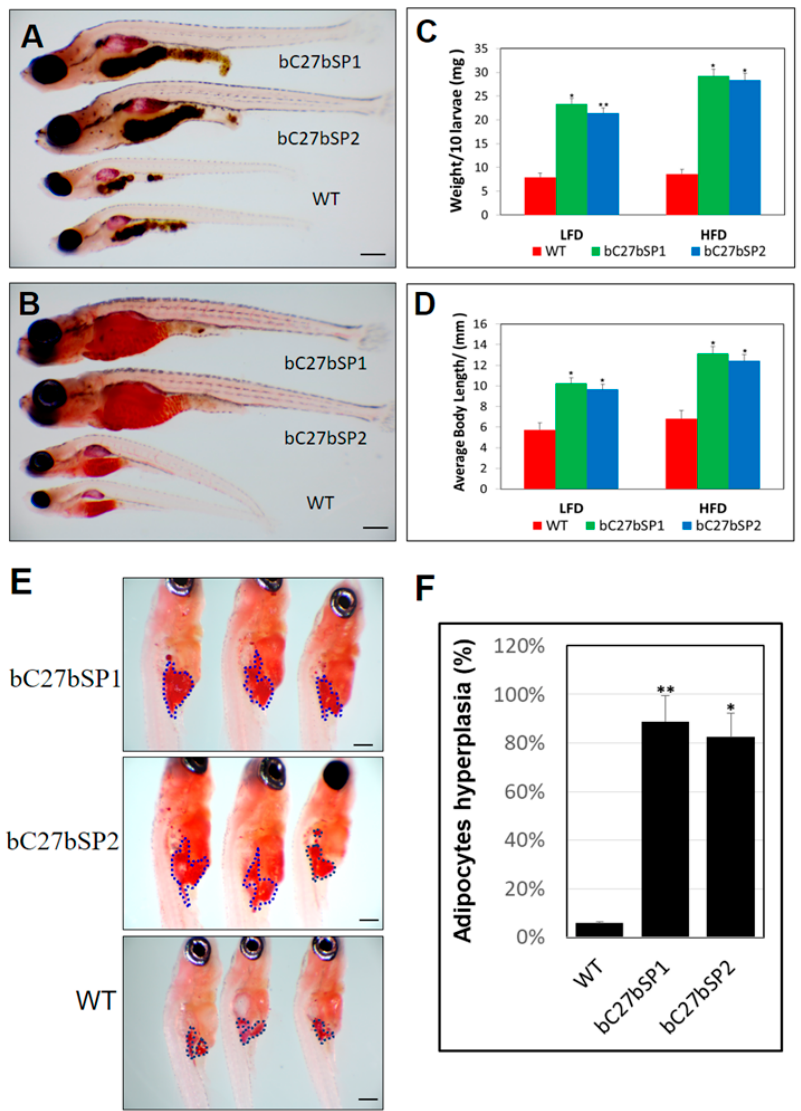
Figure 6. miR-27b depletion results in enhancement of bC27bSPs larval growth and adipocyte formation. ( A ) Representative images of bC7aSPs and WT larvae fed a HFD and ( B ) fed a LFD, 40× magnification, scale bars: 200 µm. ( C ) Average body weights of bC27bSPs and WT larvae fed a LFD or HFD ( n = 40–50 for each groups). * p < 0.01, and ** p < 0.005. ( D ) Average body lengths of bC27bSPs and WT larvae fed a LFD or HFD ( n = 40–50 for each groups). * p < 0.01, and ** p < 0.005. ( E ) ORO-stained visceral adipocytes in bC27bSPs when compared to WT controls at 24 dpf. Visceral adipocytes are circled. 110X magnification, scale bars: 200 µm. ( F ) The percentage of bC27bSPs and WT larvae